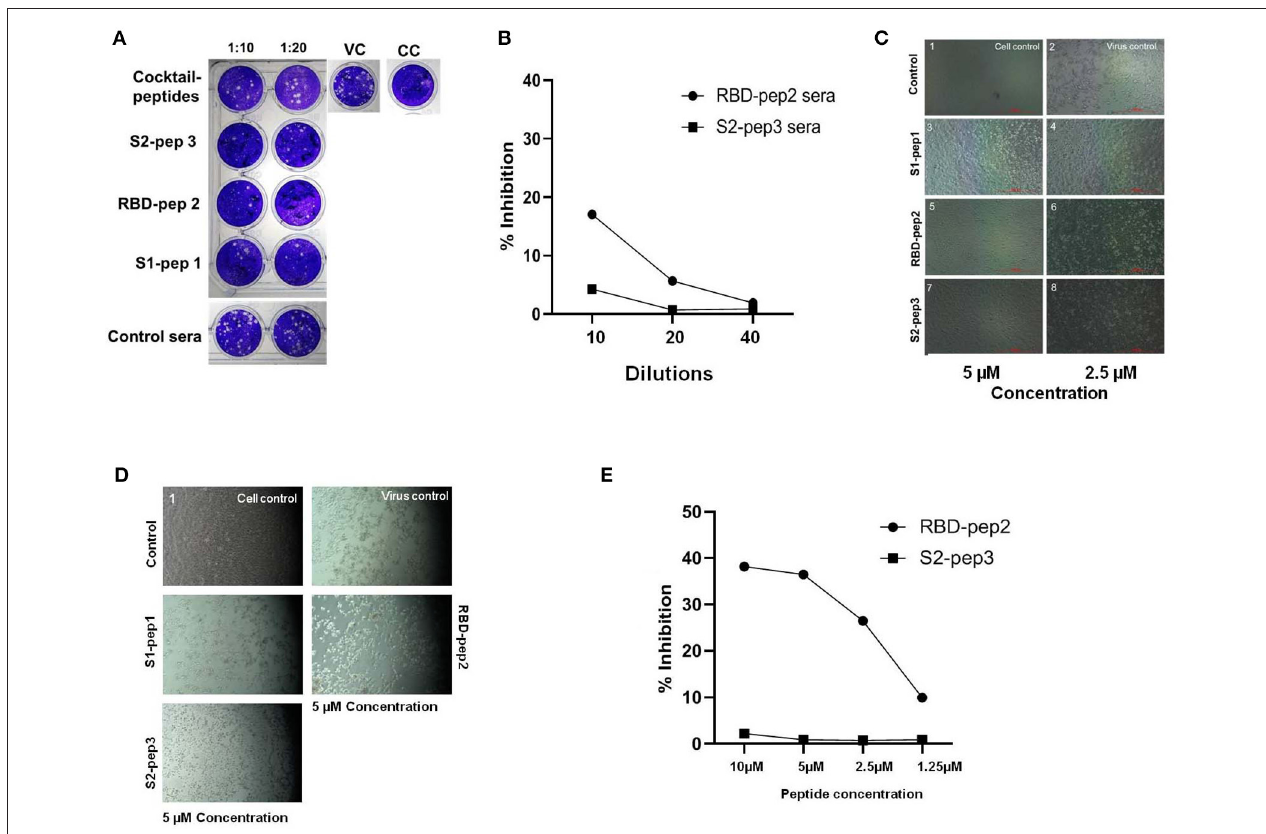
FIGURE 5 | In vitro neutralization and anti-viral inhibition assay. (A) Plaque assays were performed using SARS-CoV-2 (USA-WA1/2020) isolate in Vero E6 cells. Sera were incubated with 50 PFU of viruses at 1:10 and 1:20 dilutions for 1h at room temperature (RT) and allowed to infect the Vero E6 monolayer of cells seeded onto 24-well plates. Following 1h of adsorption, the plate was washed with 2% Dulbecco’s Modified Eagle Medium (DMEM) and overlaid with 2% carboxymethyl cellulose (CMC) prepared in DMEM. Forty-eight hour p.i., the plates were fixed with 6% formalin for 4h at RT and stained with 1% crystal violet to visualize the plaques. VC, Virus control; CC, cell control. (B) The ACE2-RBD competition assay was performed in ELISA format showing percentage inhibition of SARS-CoV-2 RBD binding ACE2 in the presence of RBD-pep2 sera. (C) Cytopathic effect-(CPE) based viral inhibition assay with peptides. The peptides with different concentrations were incubated with 10 MOI of wild type SARS-CoV-2 virus for 30min at RT and allowed to infect the Vero E6 monolayer of cells seeded onto 12-well plates. After 1h of adsorption, the plate was washed and maintained in 2% DMEM growth media. Forty-eight hour p.i., the CPE were visualized in the microscope. (D) The CPE-based viral inhibition assay with peptides after virus attachment. (E) The ACE2-RBD competition ELISA with RBD-pep 2. The RBD-pep2 was incubated at different concentrations with 2 µ g of soluble RBD protein for 30min at RT. The mix was then transferred to the ELISA plate coated with soluble ACE2 and further incubated for 1h at RT. The plate was then washed and an HRP- conjugated anti-His antibody was added and incubated for 1h at RT; the plate was washed two times with PBST and then developed with a TMB substrate. The reaction was stopped by adding 2N H 2 SO 4 stop solution and absorbance was measured at